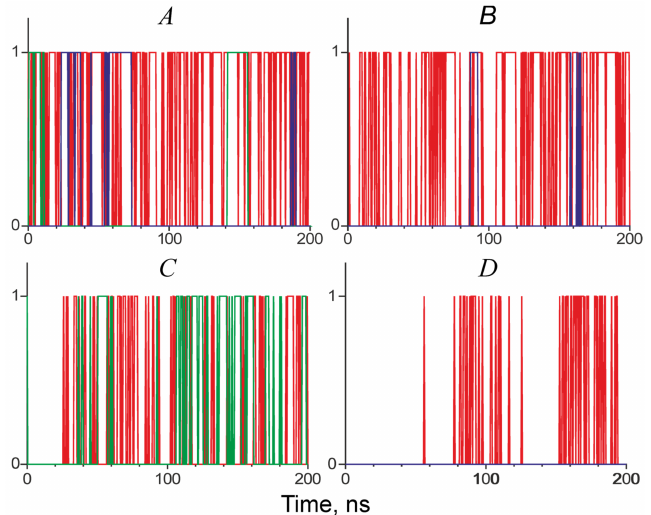
Figure 8. The time course of the existence of h -bonds between E218 and D (or V)219 Tpm residues and K326 and K328 residues of neighboring actin monomers during a 200 ns-long MD trajectory with WT Tpm ( A , C ) and D219V Tpm ( B , D ); vertical axis: one means at least one h -bond between the residues, zero otherwise; ( A – D ) correspond to two different Tpm strands. The h -bond between E218 of Tpm and K326 of actin is red; the h -bond between E218 of Tpm and K328 of actin is blue; and the h -bond between D (or V)219 Tpm residue and K326 of actin is